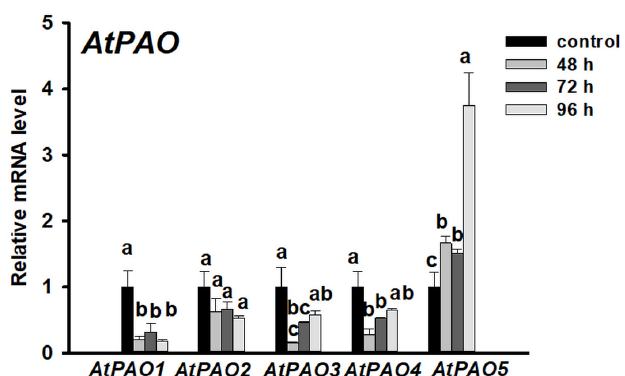
Figure 3. Expression of polyamine oxidase (PAO) genes during direct shoot organogenesis on Arabidopsis roots. Relative mRNA levels of AtPAO1 , AtPAO2 , AtPAO3 , AtPAO4 , and AtPAO5 genes after 48, 72 and 96 h of cytokinin induction representing the organ conversion (48 h), the early (72 h) and late (96 h) shoot promeristem phases [7]. The mRNA levels of the UBIQUITIN 1 (At3G52590) and PP2A3 (At1G13320.1) genes were used for gene expression normalization. The mRNA level of the untreated root tissue was used as control (relative mRNA level: 1). Data were averaged from three independent biological experiments with three technical replicates each. Standard errors are shown on the columns. The significance of difference between sets of data was determined by one-way analysis of variance (ANOVA) following Duncan’s multiple range tests; a p -value of less than 0.05 was considered significant as indicated by different